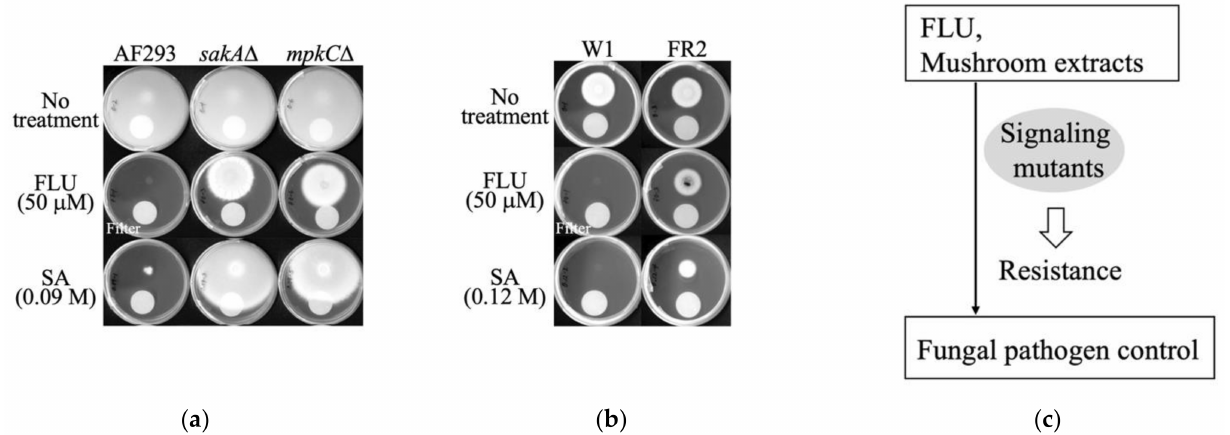
Figure 2. Resistance of antioxidant signaling mutants of fungi to FLU and SA. ( a ) Response of A. fumigatus wild type (AF293) and MAPK mutants ( sakA ∆ , mpkC ∆ ). ( b ) Response of P. expansum wild type (W1) and antioxidant mutant (FR2). ( c ) Diagram describing the tolerance of fungal signaling mutants to FLU or the mushroom extract TcM. The round circle at the lower half of each plate indicates a membrane filter where SA or DMSO (no treatment control) was applied. Fungal radial growth is shown at the upper half of each plate; note that A. fumigatus fully covered the control (no treatment) plates, reflecting rapid